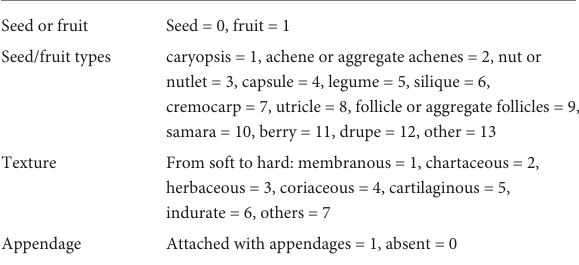
TABLE 1 Assignment of numerical values to the traits of